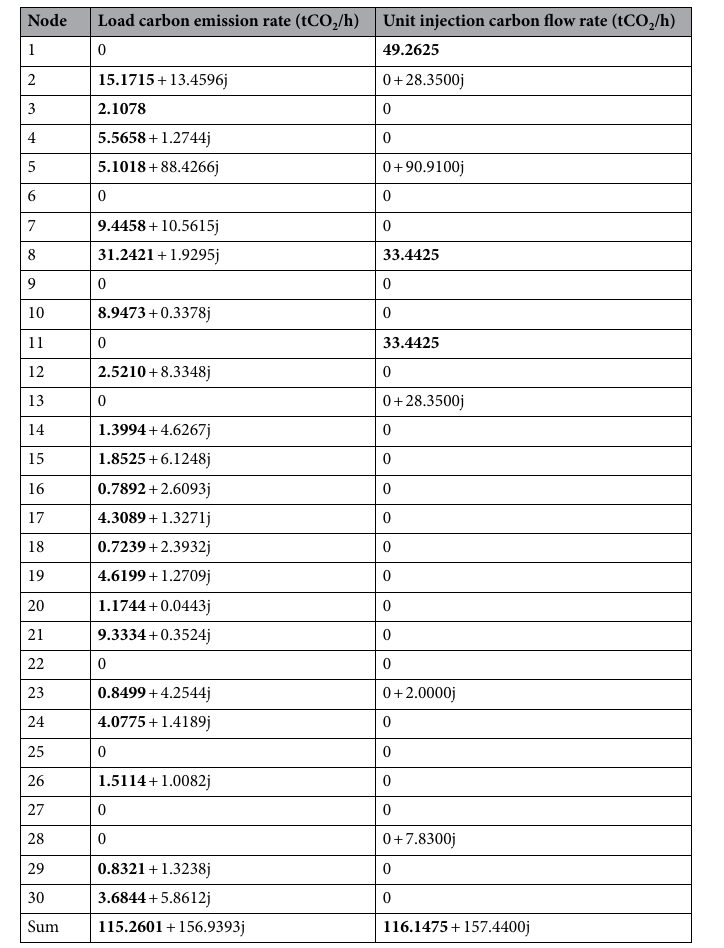
Table 7. Load carbon emission flow rate and unit injected carbon emission flow rate. Significance values are in bold.